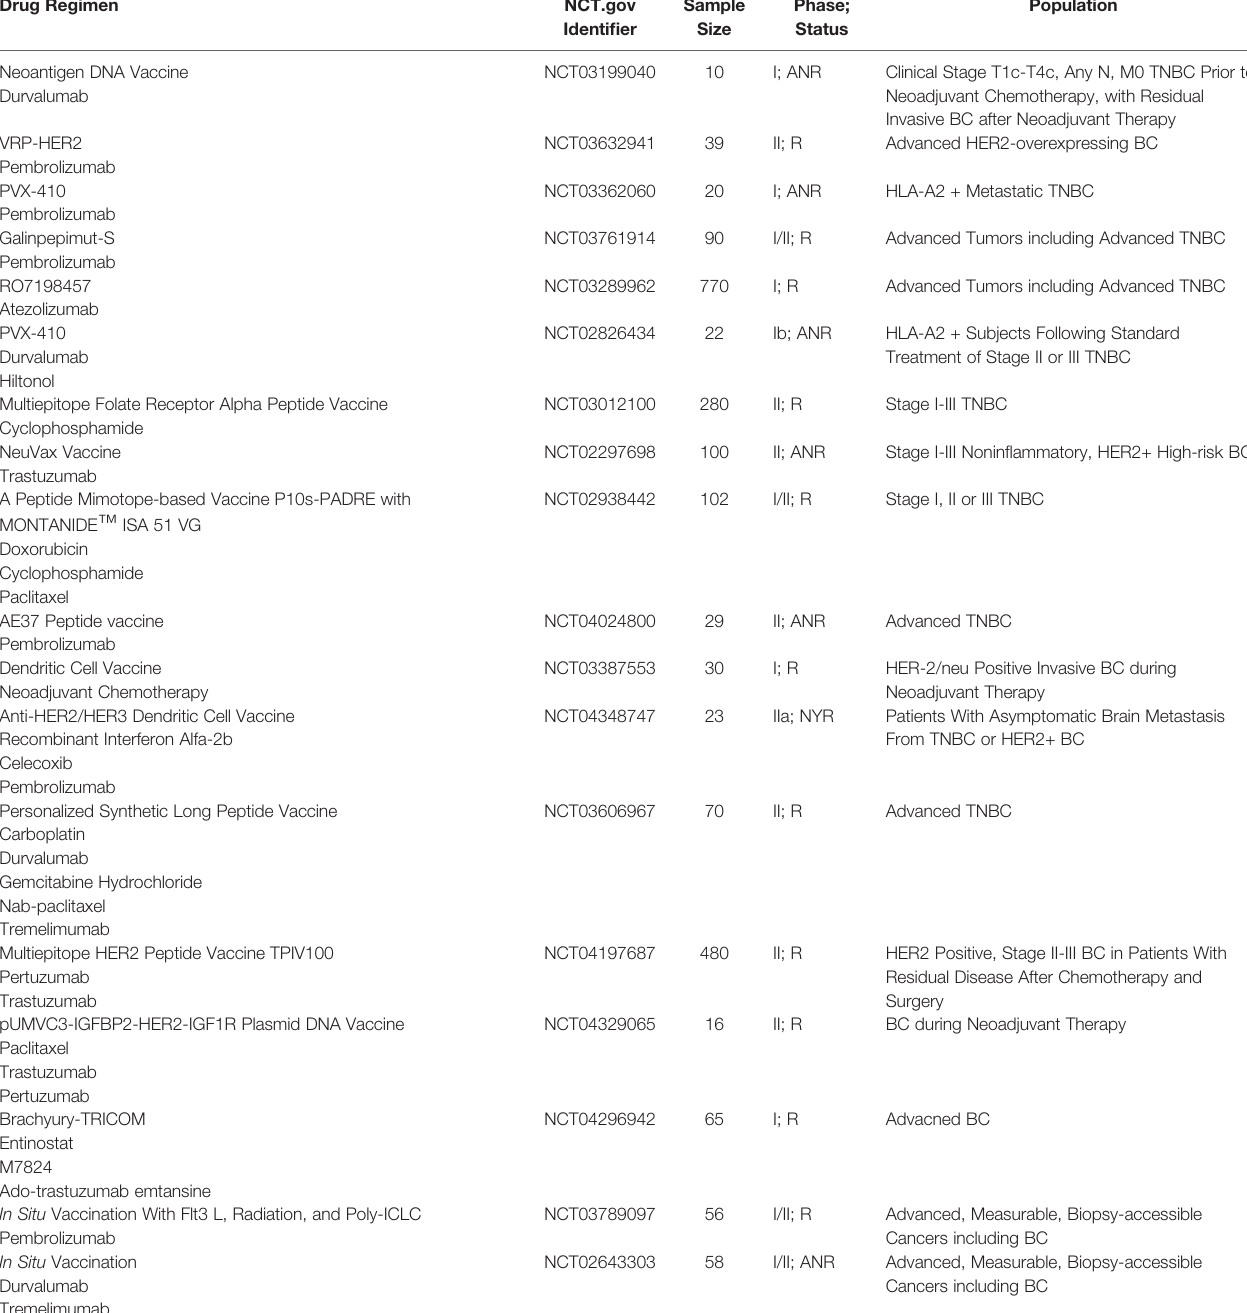
TABLE 2 | Ongoing trials of tumor vaccine-based combination therapy for BCs (data from ClinicalTrials.gov). Drug